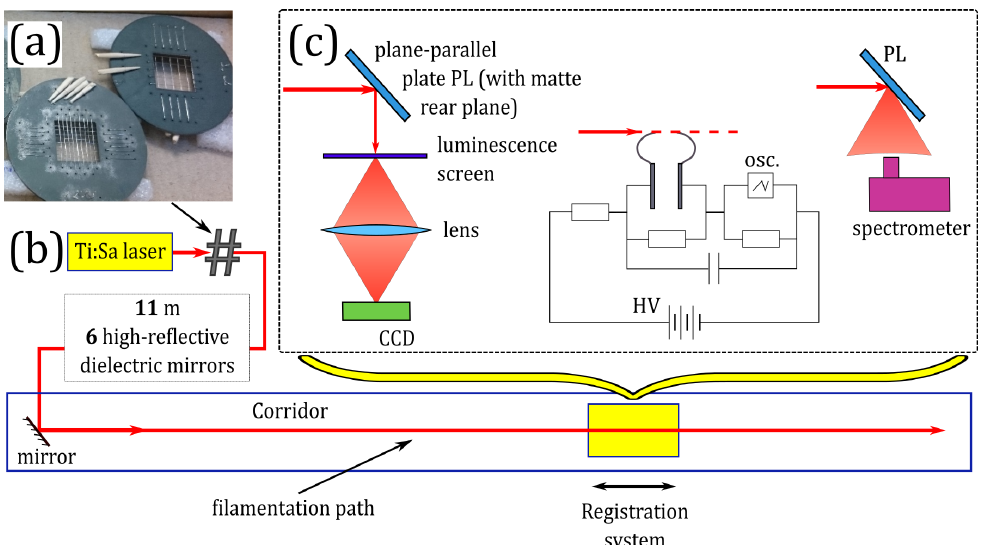
Figure 1. ( a ) Photo of wire meshes used for the beam regularization. Scheme of ( b ) experimental setup and ( c ) portable registration system. The latter allowed us to record the transverse fluence distributions ( left ), check the discharge triggering ( center ), and record the pulse spectrum ( right ). The symbol “#” in ( b ) indicates the mesh inserted into the beam. In ( c ), PL is a plane-parallel plate with a single matted surface, HV is a high-voltage supply, Osc is an